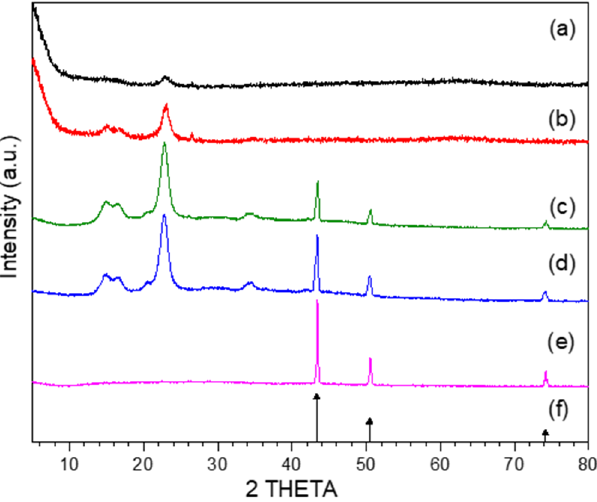
Figure 1. XRD patterns of nanoparticles obtained at different contents of precursor salt and cotton: (a) cotton (UT-C), (b) heat-treated cotton (HT-C), (c) CCuNP2.5, (d) CCuNP5.0, (e) CCuNP10.0, and (f) standard copper XRD (JCPDS 4–836).